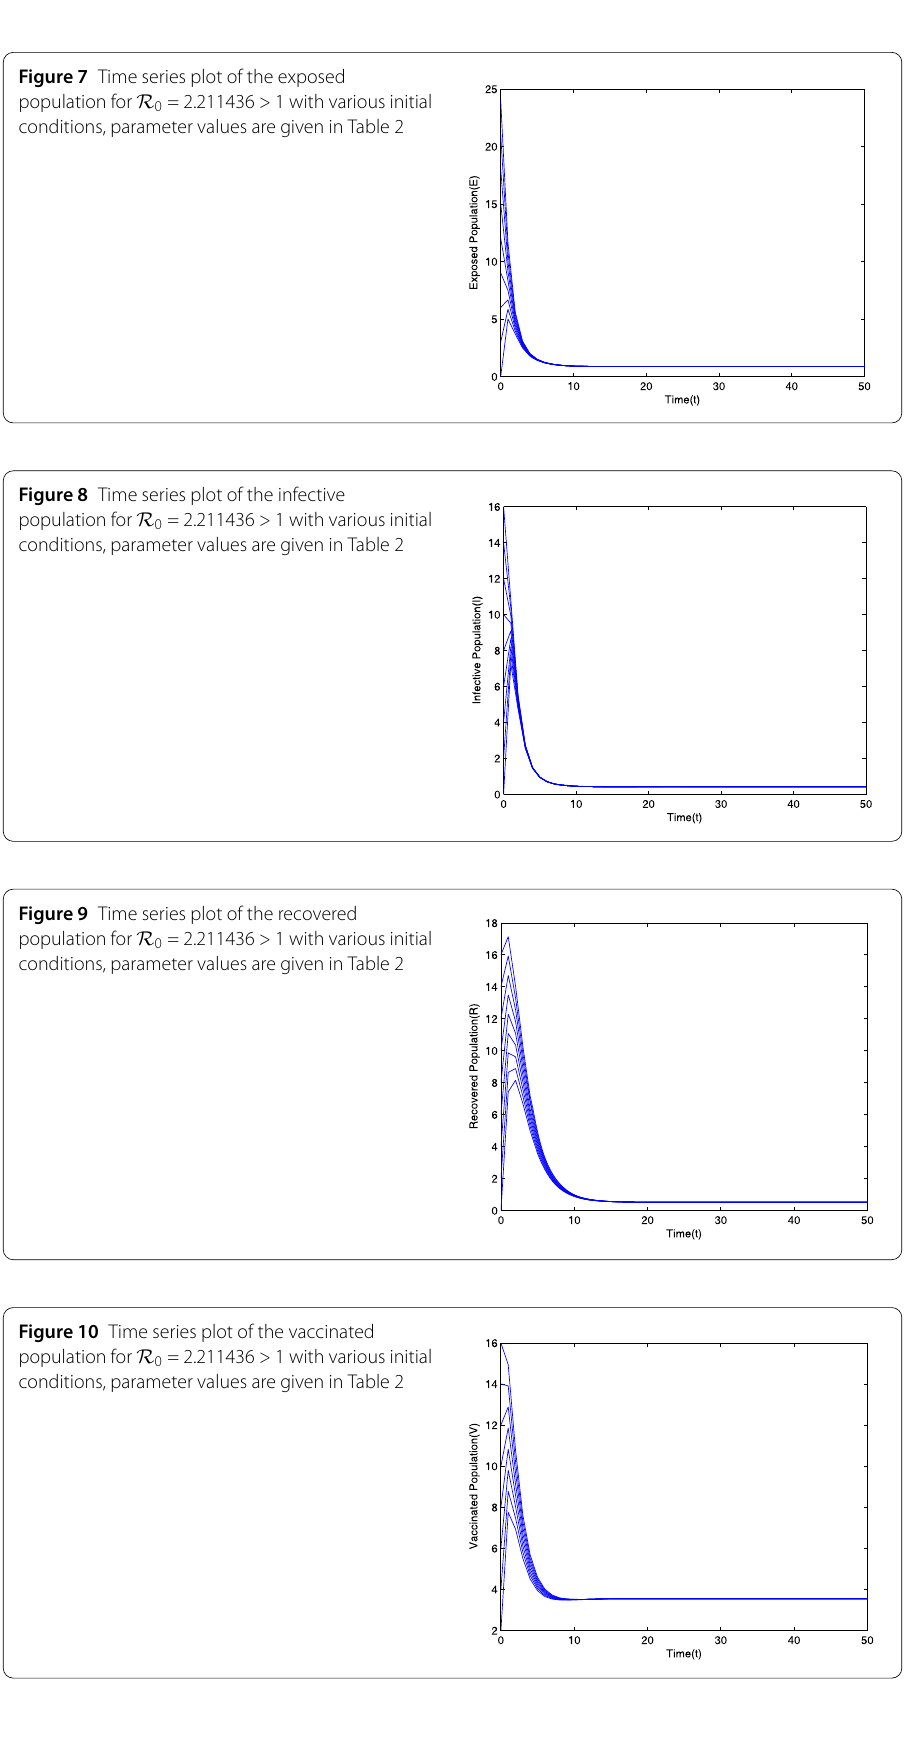
Figure 7 Time series plot of the exposed population for R 0 = 2.211436 > 1 with various initial conditions, parameter values are given in Table 2